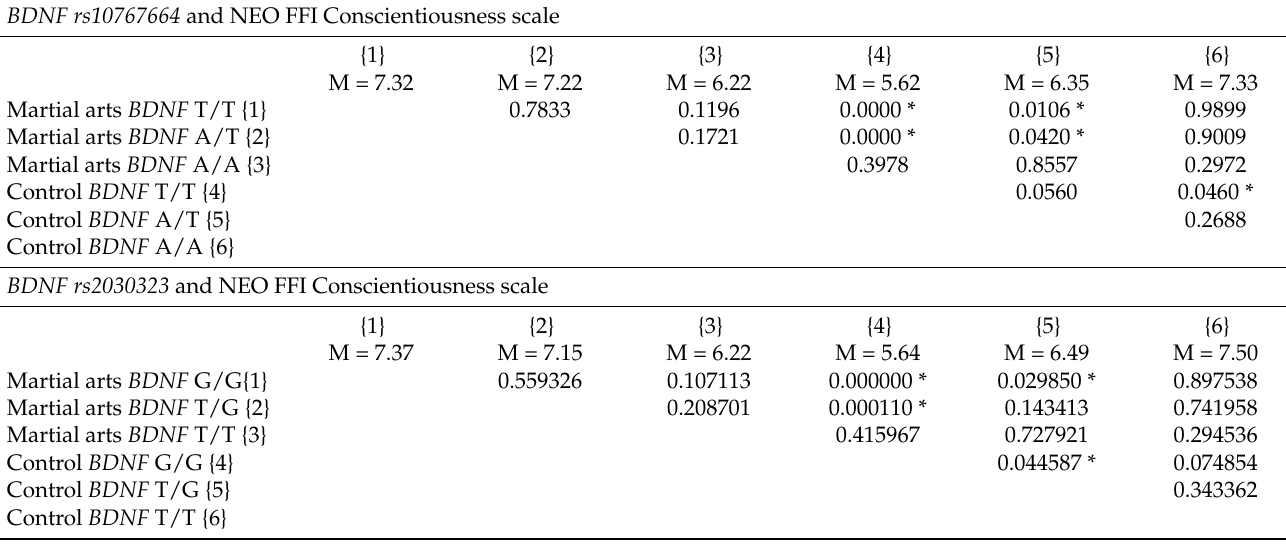
Table 6. Post hoc analysis of interactions between martial arts/control and BDNF rs10767664/ BDNF rs2030323, and the conscientiousness